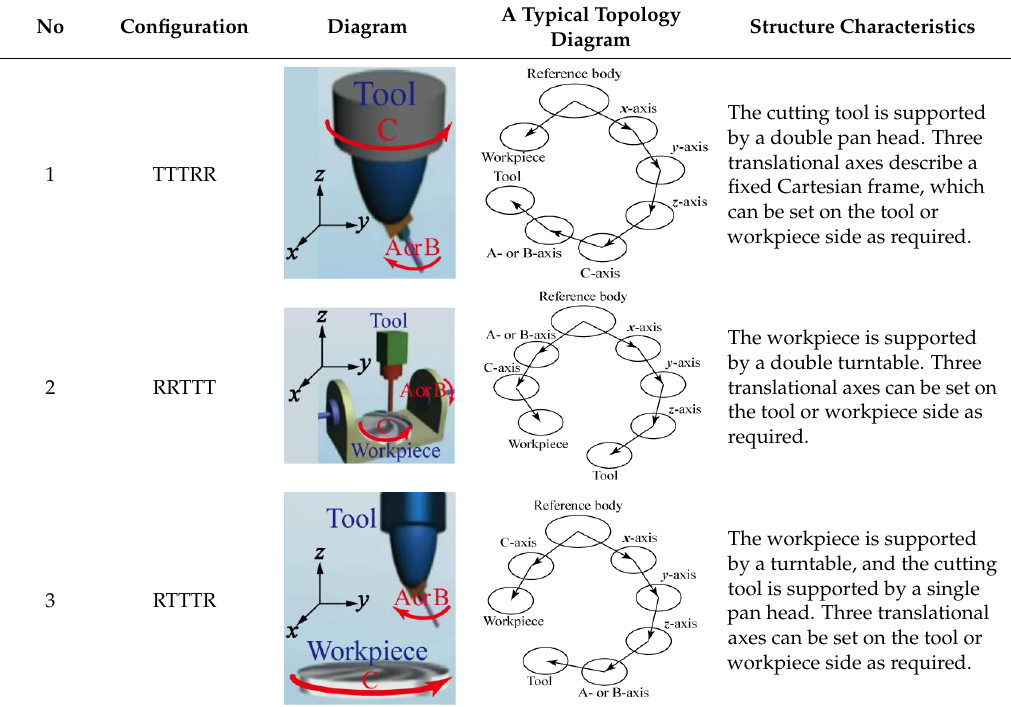
Table 1. Characteristics of three structural configurations of 5-axis machine tools.